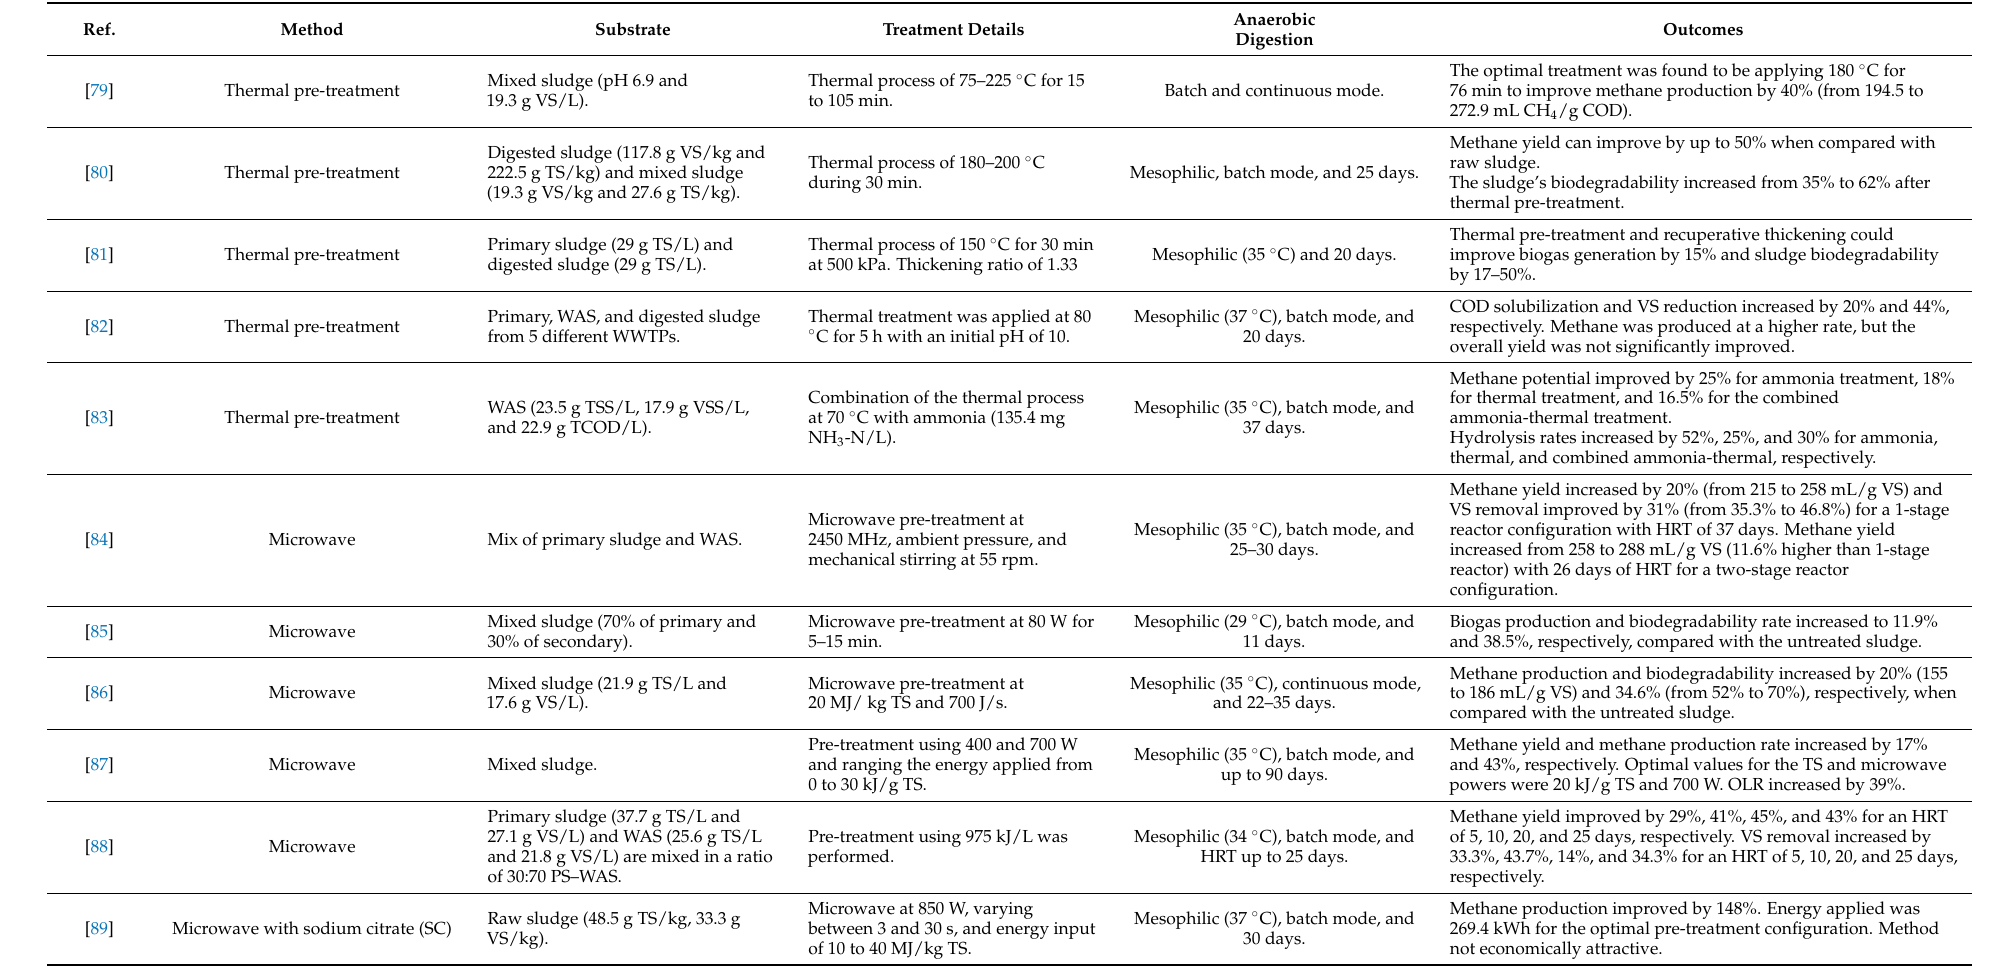
Table 3. Pre-treatment methods applied on sewage sludge to improve biogas